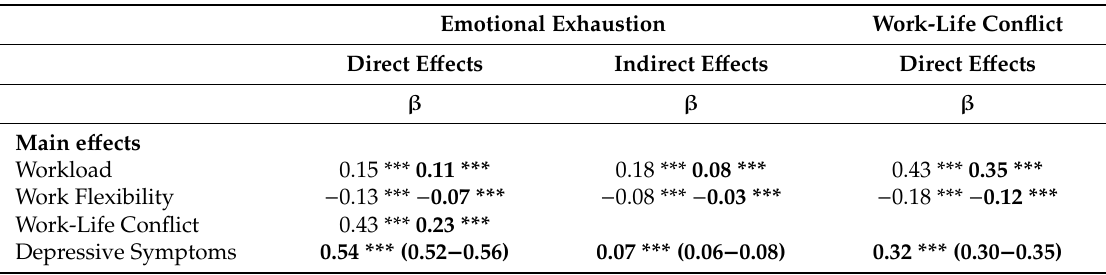
Table 4. Comparison of standardized path coe ffi cients with and without depressive